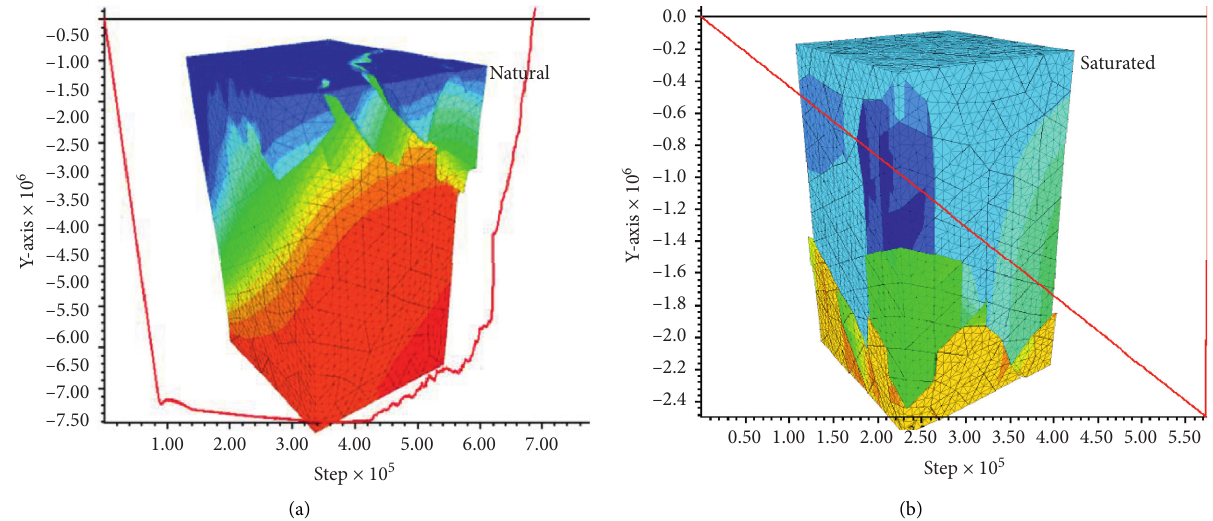
Figure 7: Numerical test on the uniaxial compressive strength of the rock mass.